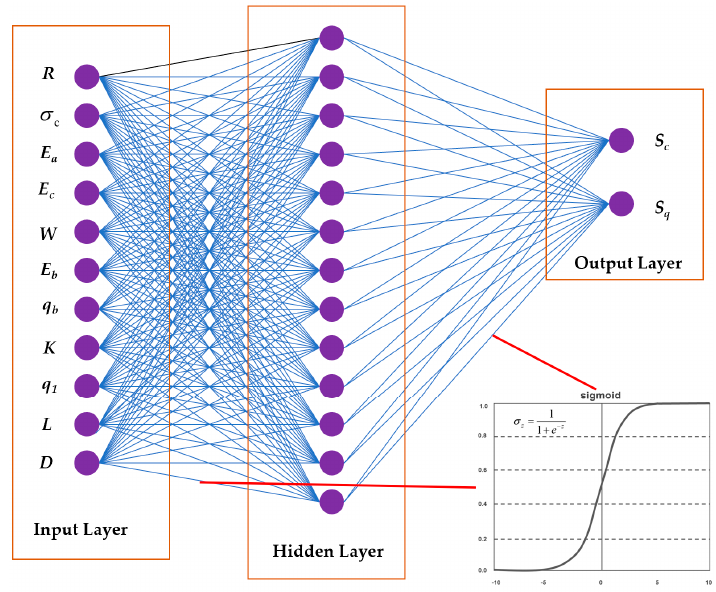
Figure 7. Schematic diagram of GA_BP neural network topology.